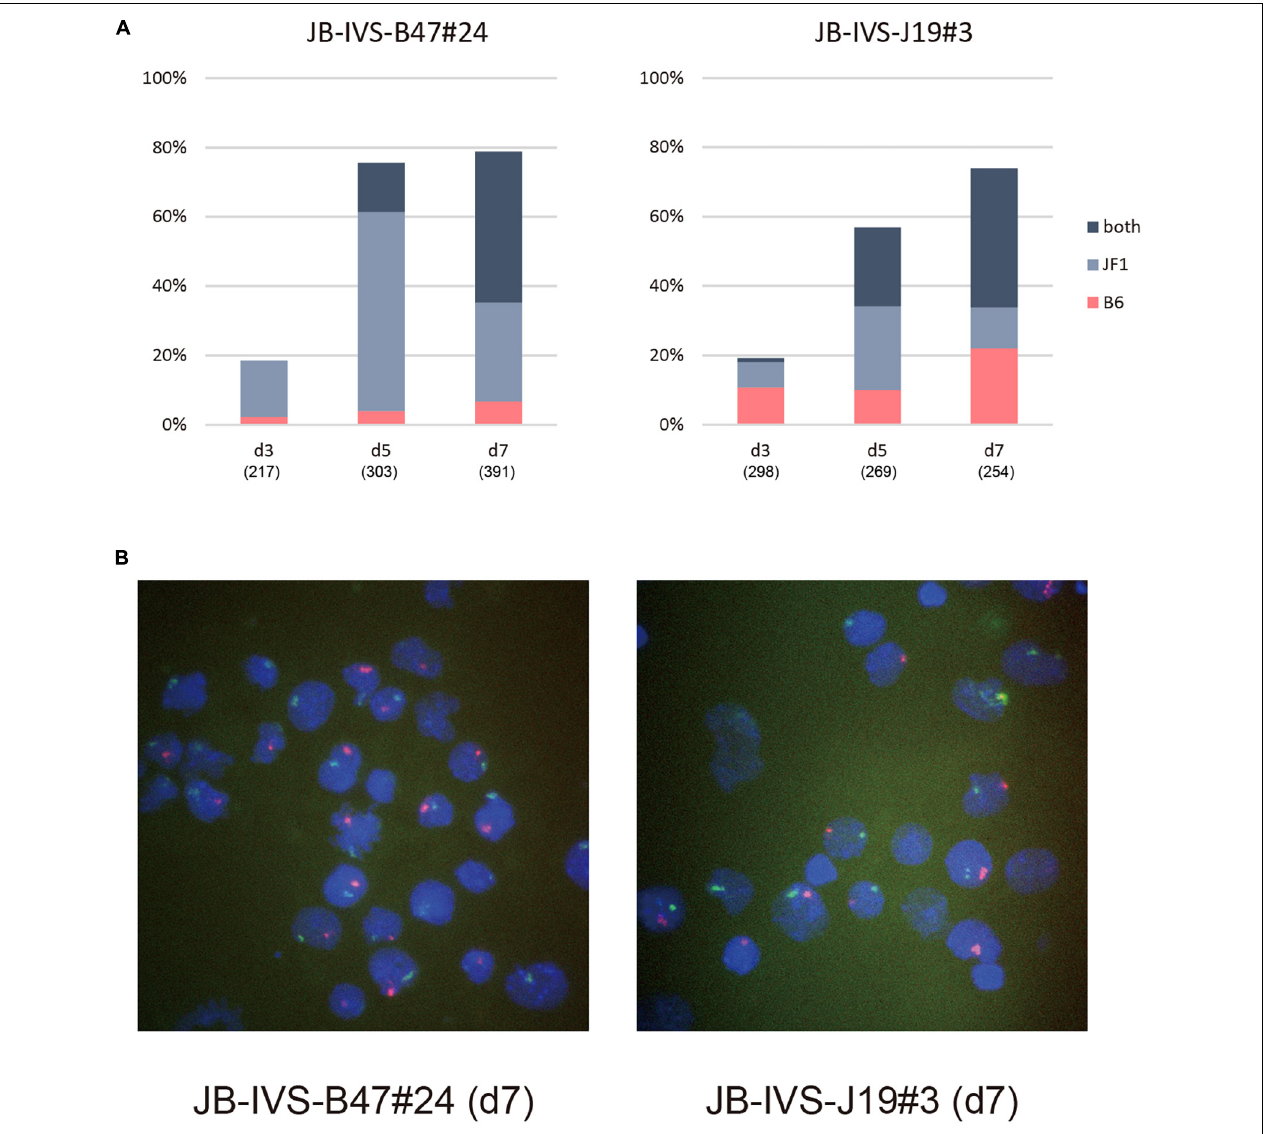
FIGURE 3 | Allele-specific RNA-FISH for Xist in IVS-B47#24 and IVS-J19#3. (A) Proportion of nuclei harboring the Xist cloud of the X B6 or X JF1 in origin or both in respective differentiating ESCs for d3 up to d7. IVS-B47#24 carries Xist CAGIVS on the X B6 and IVS-J19#3 on the X JF1 . (B) Representative images of allele-specific RNA-FISH for Xist in each ESC line on d7. Xist RNA originated from the X B6 and X JF1 is shown in red and green, respectively.